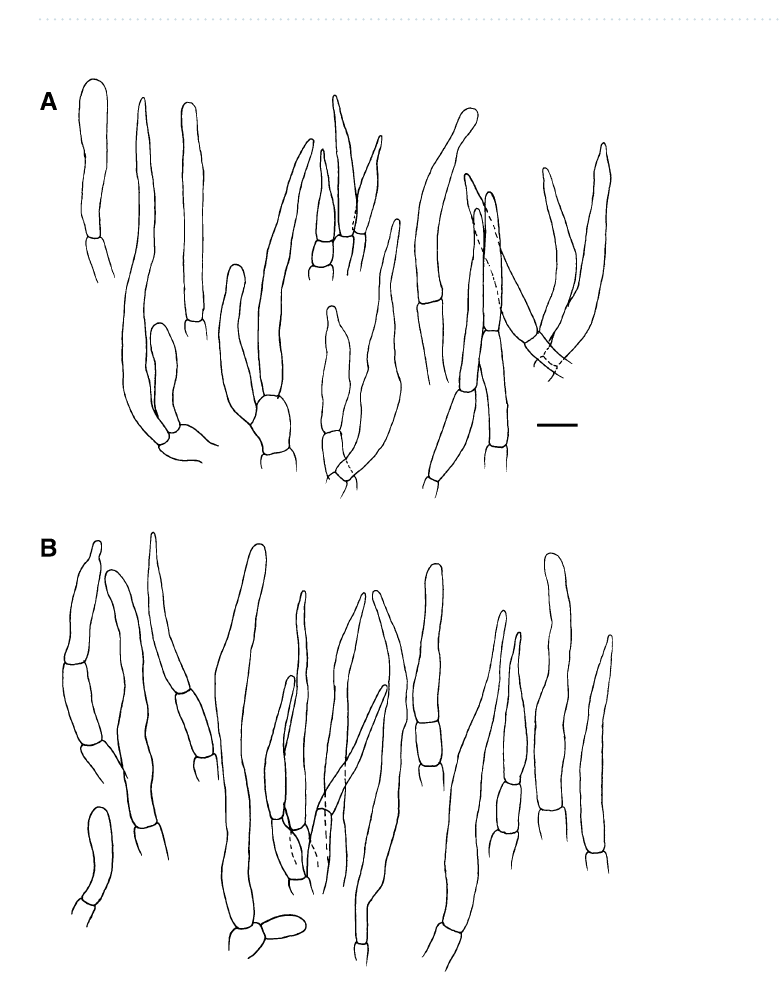
Figure 9. Spore ornamentation taken from scanning electron microscope. Russula luteonana (holotype, BBH41120). Scale bar = 2 μm.